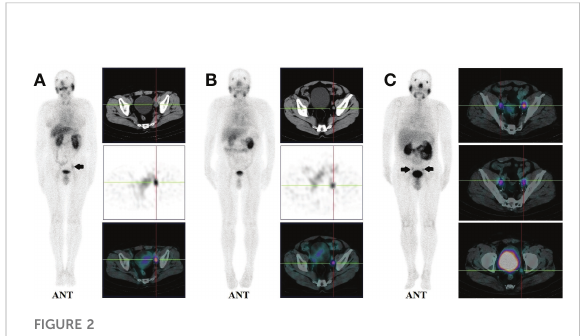
FIGURE 2 (A) : Images of biochemically recurrent prostate cancer in a 72- year-old male with rising PSA levels after radical prostatectomy (PSA, 3.43 ng/ml; Gleason score, 4 + 4). Whole-body planar scintigraphy (pointed by black arrow) and transaxial SPECT/CT fusion images indicated a diameter of 13 mm lymph node metastases near the left iliac blood vessels, which shows pathological tracer uptake (SUVmax, 3.67). Final pathology con fi rmed prostate cancer metastasis. (B) : Images of biochemically recurrent prostate cancer in a 61-year-old male with rising PSA levels after radical prostatectomy (PSA, 0.73 ng/ ml; Gleason score, 4 + 5). Transaxial SPECT and fused SPECT/CT images show high 99mTc-HYNIC-PSMA uptake (SUVmax, 2.74) in subcentimeter (8 mm) lesions, as determined by